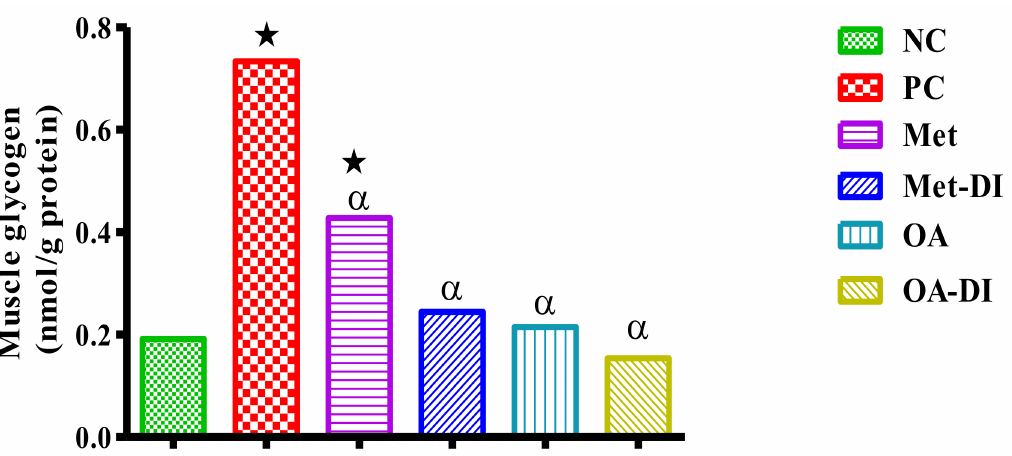
Figure 5. Effects of OA on muscle glycogen concentrations of rats that continued with HFHC diet and those that changed diet or had diet intervention during treatment period. Values are presented as mean. (cid:70) = p < 0.05 denotes comparison with NC; α = p < 0.05 denotes comparison with